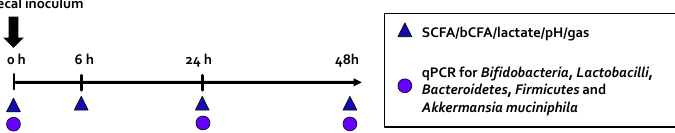
Figure 1. Schematic representation of the experimental design in this study to investigate the prebiotic potential of baobab fruit pulp powder (BP). ( A ) First, upper gastrointestinal absorption was simulated through dialysis of the baobab fruit pulp powder. Second, 48 h fecal batch incubations were performed to assess the prebiotic potential of the dialyzed baobab fruit pulp powder on fermentation products ( ) and levels of specific taxonomic groups via qPCR ( ) com- pared to ‘no substrate control’ incubations for three healthy adult donors. ( B ) Sampling scheme to evaluate the effect of the dialyzed baobab fruit pulp powder. SCFA = short-chain fatty acid, bCFA = branched-chain fatty acid, qPCR = quantitative polymerase chain reaction. 2.3. Short-Term Colonic Batch Incubations Short-term colonic batch incubations were performed to simulate the proximal colon of three healthy adults as previously described by Van den Abbeele et al. [25] with minor modifications. Briefly, 13 mL of concentrated colonic background medium (25.2 g/L K 2 HPO 4 , 79.0 g/L KH 2 PO 4 , 9.7 g/L NaHCO 3 (Chem-Lab NV, Zedelgem, Belgium), 9.7 g/L yeast extract, 9.7 g/L peptone (Oxoid, Aalst, Belgium), 4.8 g/L mucin, 2.4 g/L cysteine, 9.7 g/L Tween ® 80 (Sigma-Aldrich, Bornem, Belgium)) was administered to 120 mL penicillin bottles already containing 50 mL of dialyzed test product (diluted with dH 2 O to a final concentration of 4 g/L (in final volume of 70 mL)). This medium was previously demonstrated to facilitate growth of a broad spectrum of microbes belonging to various phyla (Actinobacteria, Bacteroidetes, Firmicutes, and Proteobacteria) [27]. Additionally, for each donor, a reference ‘no substrate control’ incubation was initiated simultaneously. The advantage of comparing such a ‘no substrate control’ is that any changes observed between this condition and the BP-treated condition can be attributed to BP treatment. All reactors were sealed with a rubber stopper and flushed with nitrogen to remove oxygen prior to inoculation. Fresh fecal samples were collected from three healthy adults and immediately stored in an airtight container with an AnaeroGen ® sachet (Oxoid). Fecal samples were stored at 4 °C in the anaerobic container until further processing. Fecal inocula were prepared by making a 7.5% ( w / v ) suspension of each of the freshly collected fecal samples with anaerobic phosphate buffer (8.8 g/L K 2 HPO 4 , 6.8 g/L KH 2 PO 4 , 0.1 g/L sodium thioglycolate, 0.015 g/L sodium dithionite). After homogenization (10 min, BagMixer 400, Interscience, Louvain-La-Neuve, Belgium) and removal of large particles via centrifugation (2 min, 500× g ), 7 mL of inoculum was added to each penicillin bottle, yielding a total volume of 70 mL inside each reactor. Once the inoculum was added, the incubation started and lasted for a period of 48 h. Bottles were maintained at 37 °C and